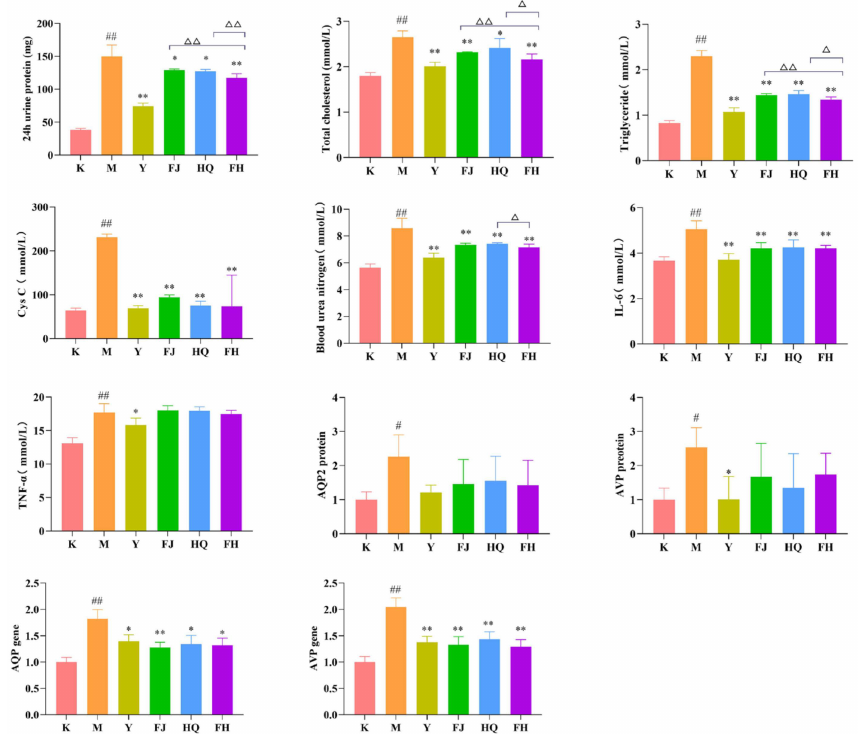
Figure 3. The 24 h urinary protein quantification, cholesterol, triglyceride, Cys C, BUN, IL-6, TNF- α levels ( n = 6), and AQP2 and AVP protein and gene expression levels ( n = 3) in each group. Compared with the K group, # p < 0.05, ## p < 0.01; compared with the M group, * p < 0.05, ** p < 0.01; compared with FH group, (cid:52) p < 0.05, (cid:52)(cid:52) p <